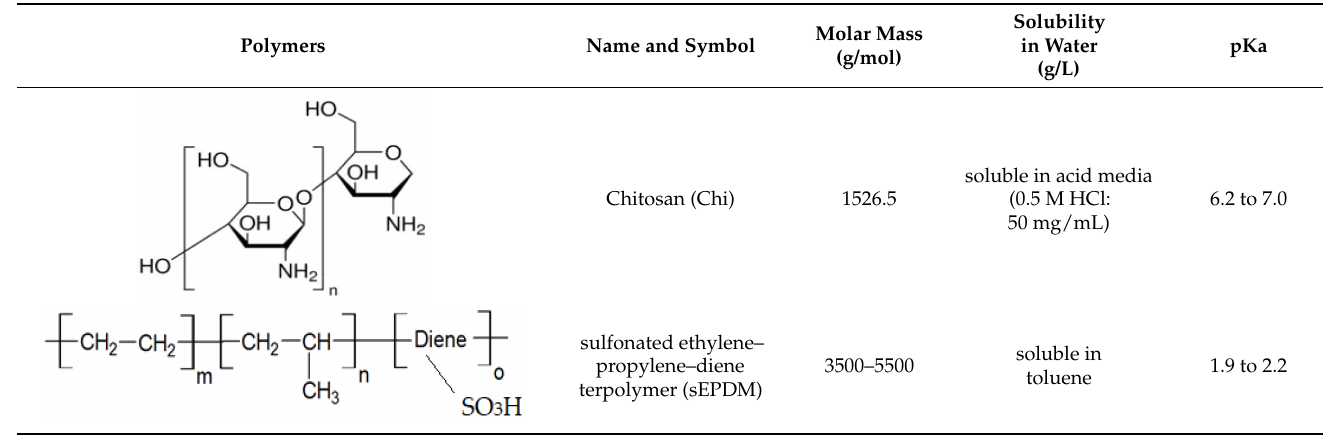
Table 2. The characteristics of the used